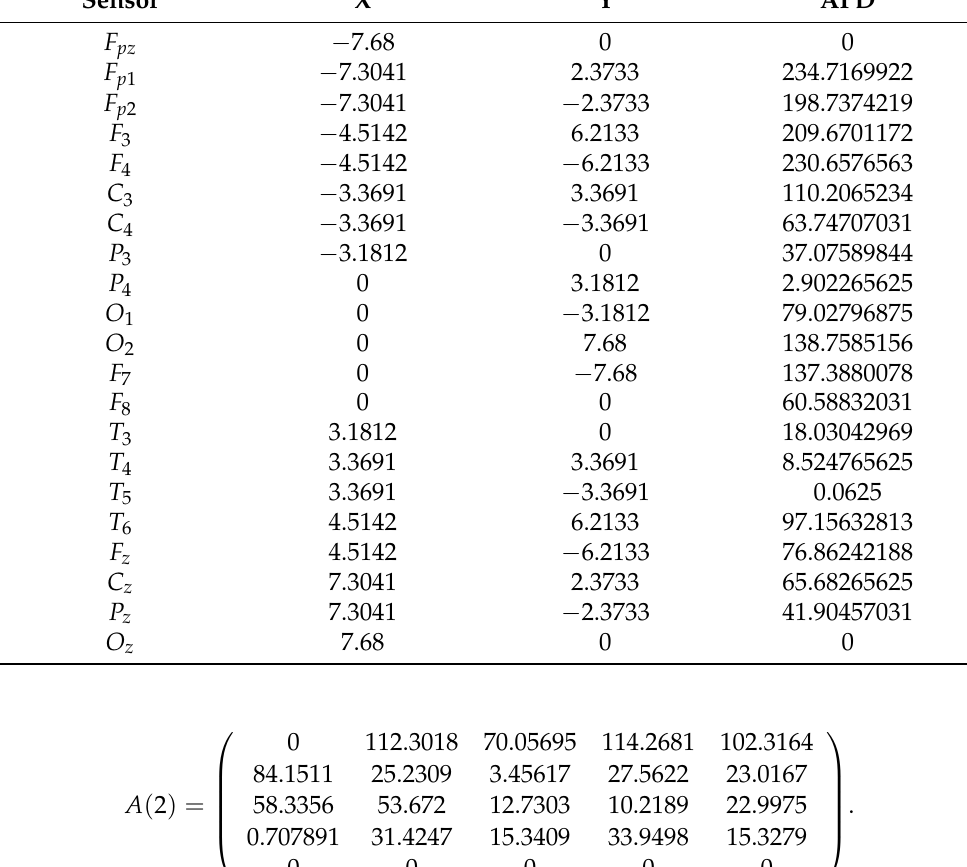
Table 6. Reordering APD at the sensor at t = 3 of patient A